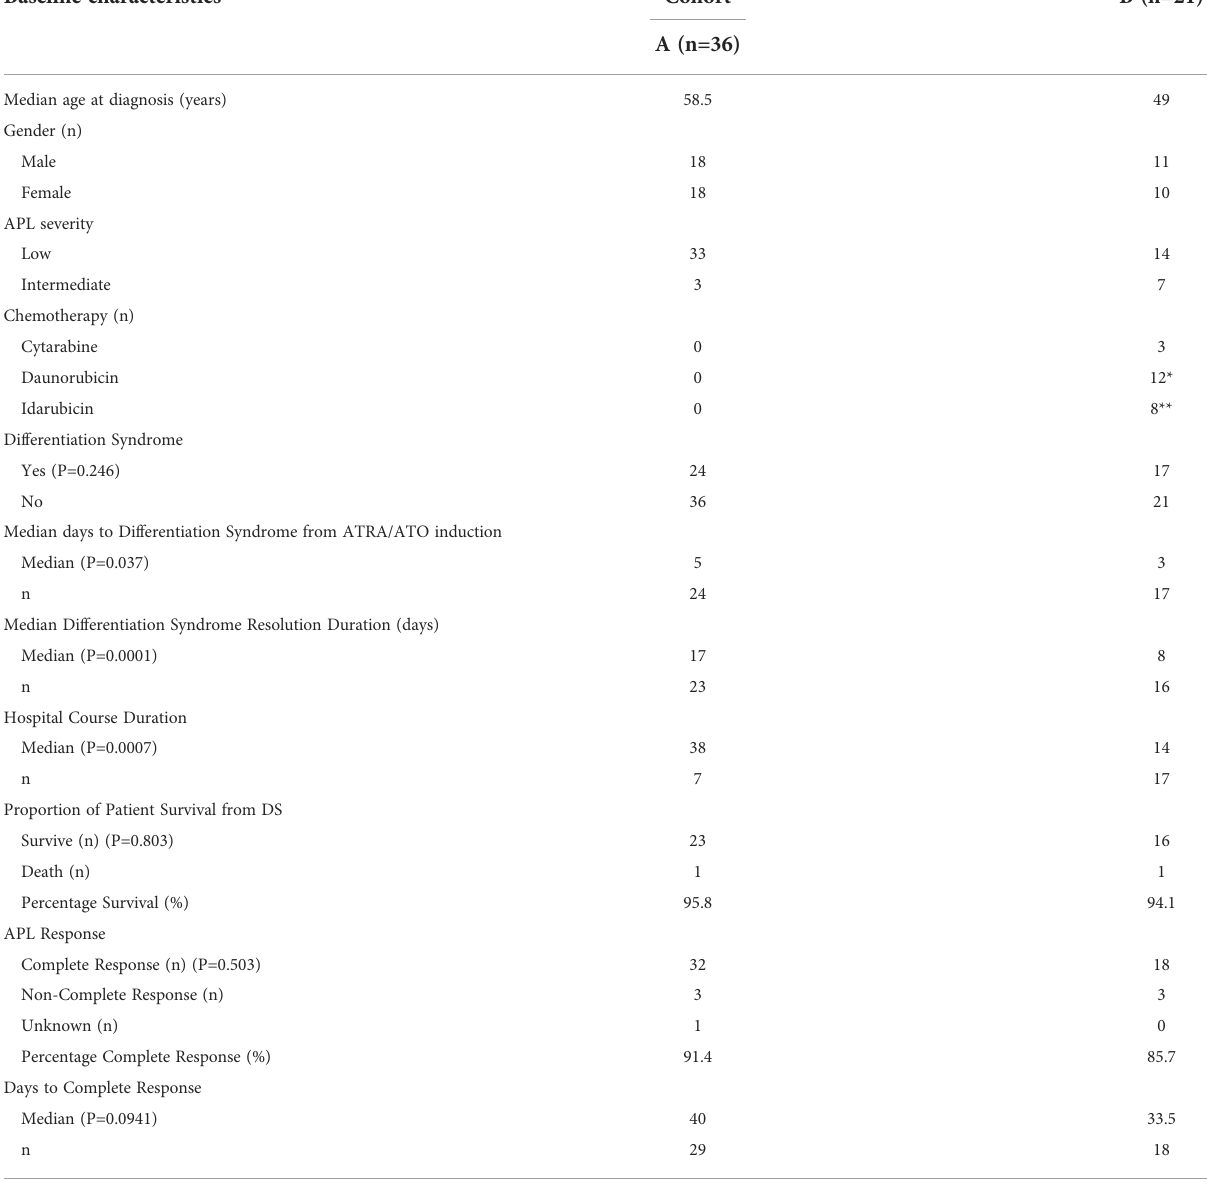
TABLE 1 Patient characteristics and outcomes. Baseline